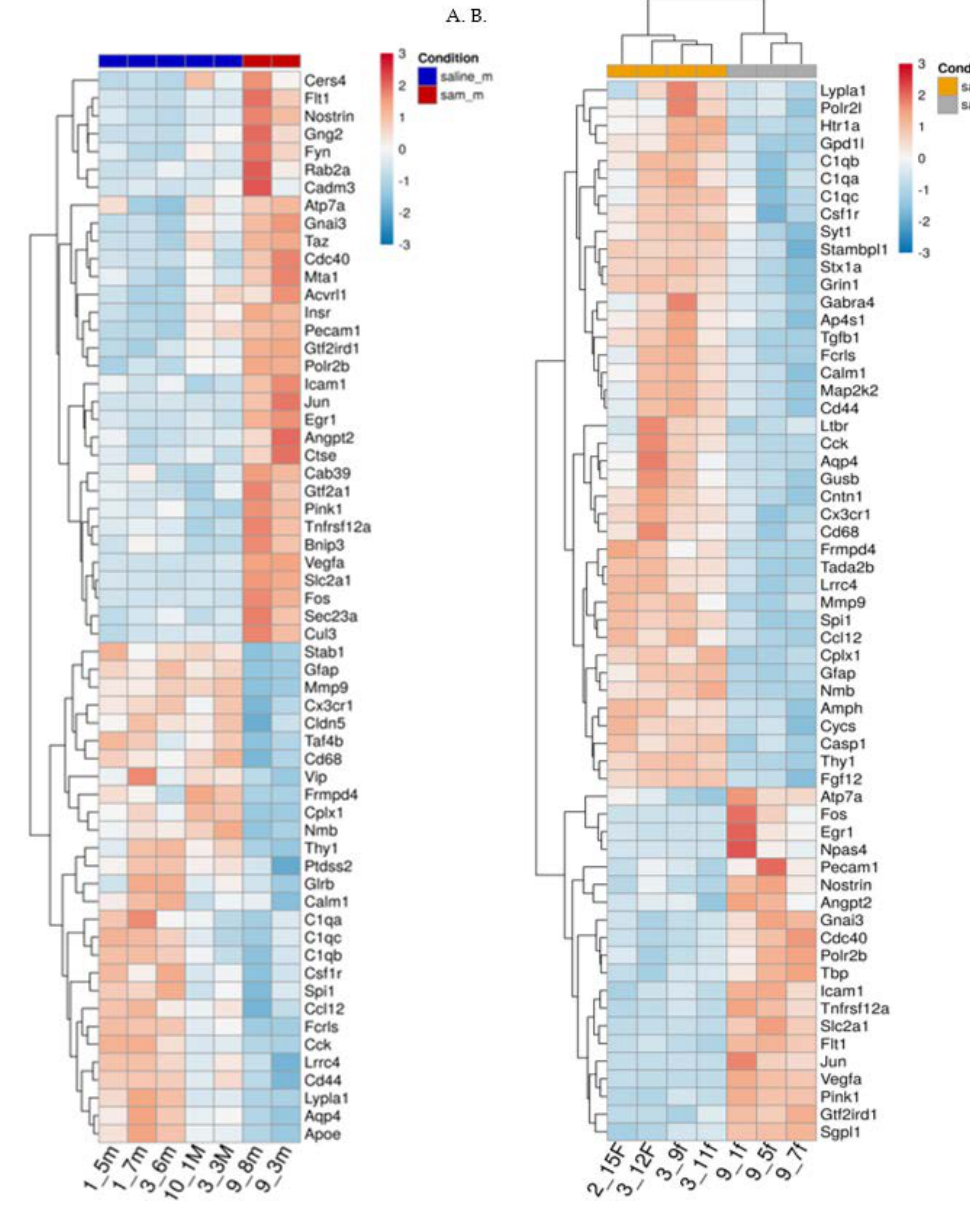
Figure 4 (A) and (B). Effect of Valproic acid (VPA) and SAMe administration on gene expression in the frontal half of the brain. Heat map of the genes significantly changed by SAMe in comparison to controls. A. left column - females, B. right column - males. Figure 5 . Result of the MA plot showing a log two-fold change in the different genes studied in SAMe-treated versus control mice in both genders. More genes were up- or downregulated in females compared to males. In both genders, most of the genes whose expression was changed by SAMe were upregulated.